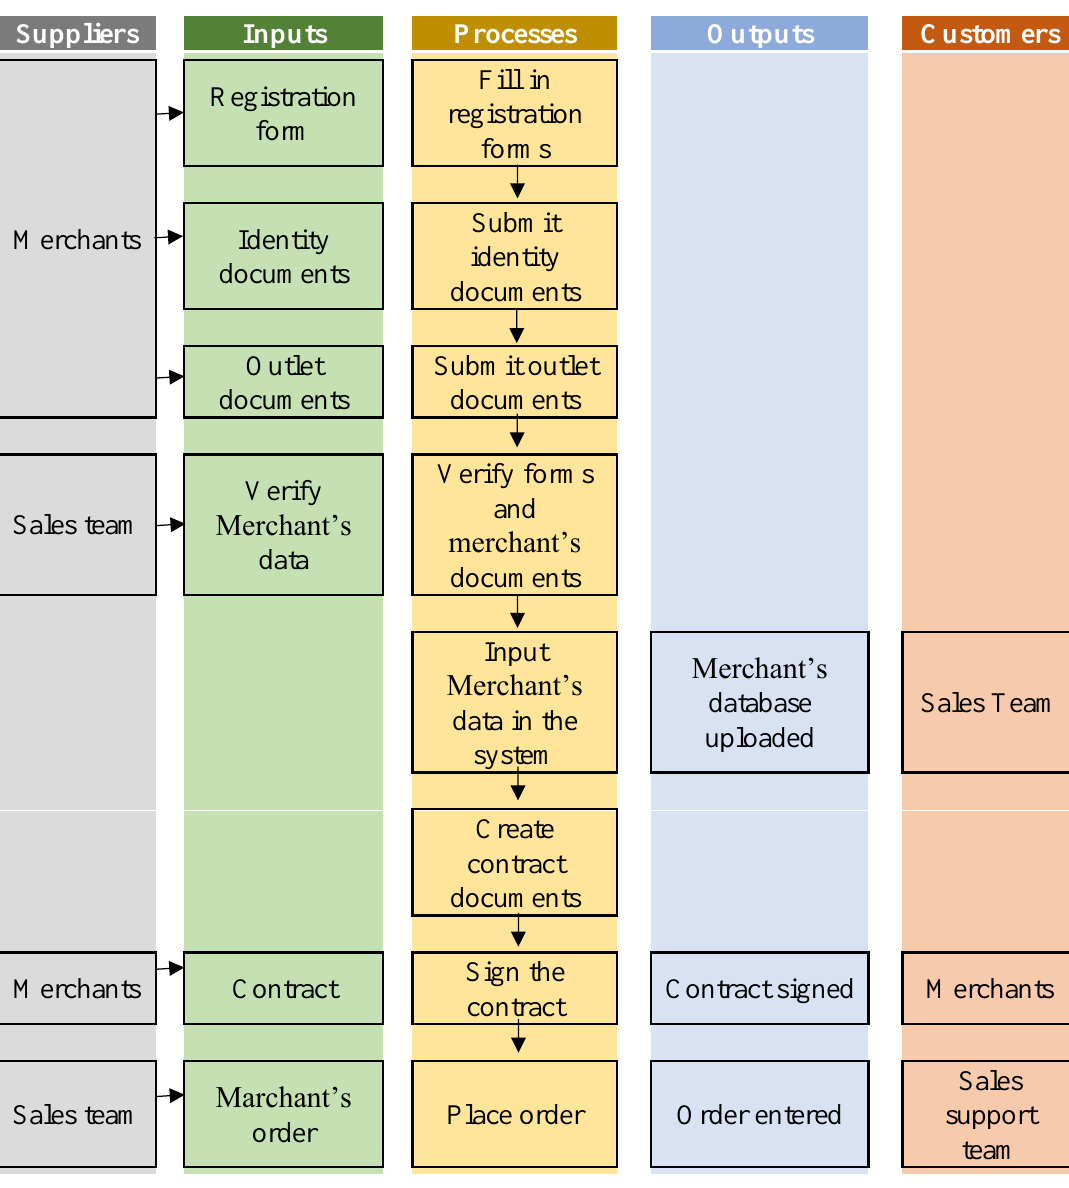
Figure 2. SIPOC diagram for onboarding stage in the sales